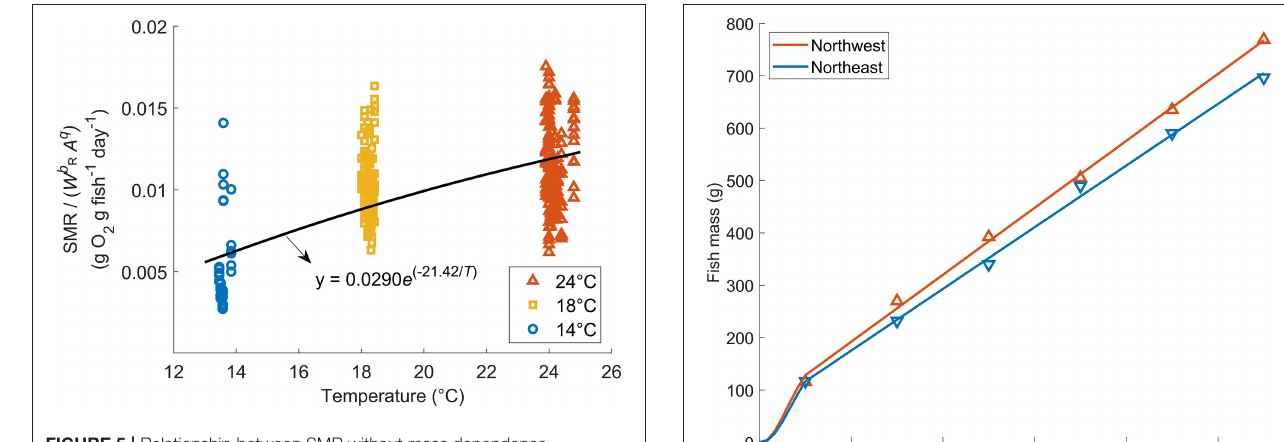
FIGURE 5 | Relationship between SMR without mass dependence W b R A q ] and temperature for Northwest stock Pacific chub mackerel. [ SMR / (cid:1) (cid:0) The solid curve is represented by the exponential regression: TABLE 2 | Comparison between the Northwest (present study) and Northeast ( Guo et al., 2019) stocks of Pacific chub mackerel including individual numbers, fork length ( FL , cm), fish mass ( W , g), experimental temperature ( ◦ C), mean seasonal temperature range experienced by each stock ( ◦ C), maximum opt , cm s − 1 , and FL s − 1 ), metabolism equation and related parameters: estimated constant a R and mass dependence b R with 95% confidence intervals, temperature dependence f(t) within the range of mean experienced temperature, and activity dependence d R .